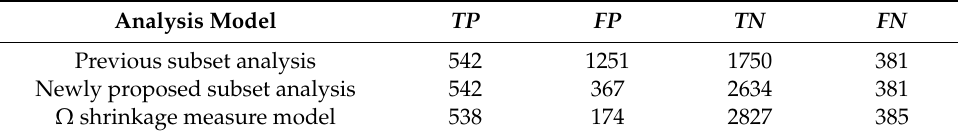
Table 3. The number of True positive, False positive, True negative, and False